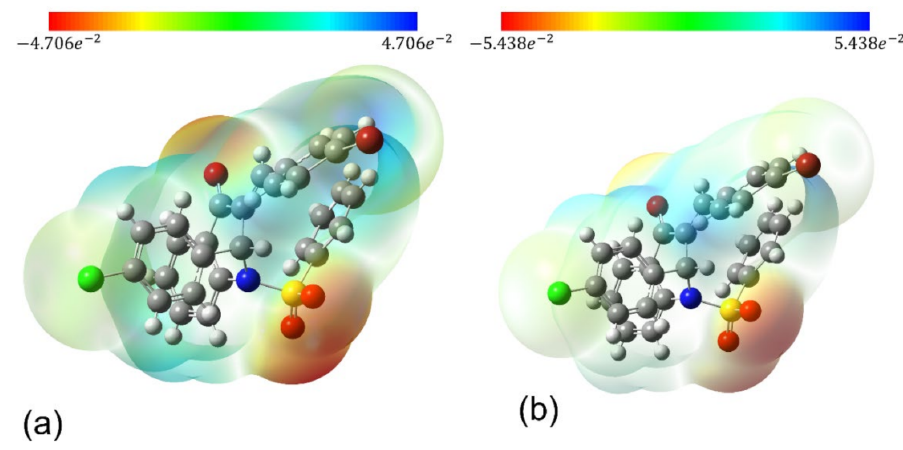
Figure 5. Molecular electrostatic potential (MEP) for QBCP isolated ( a ) and embedded ( b )